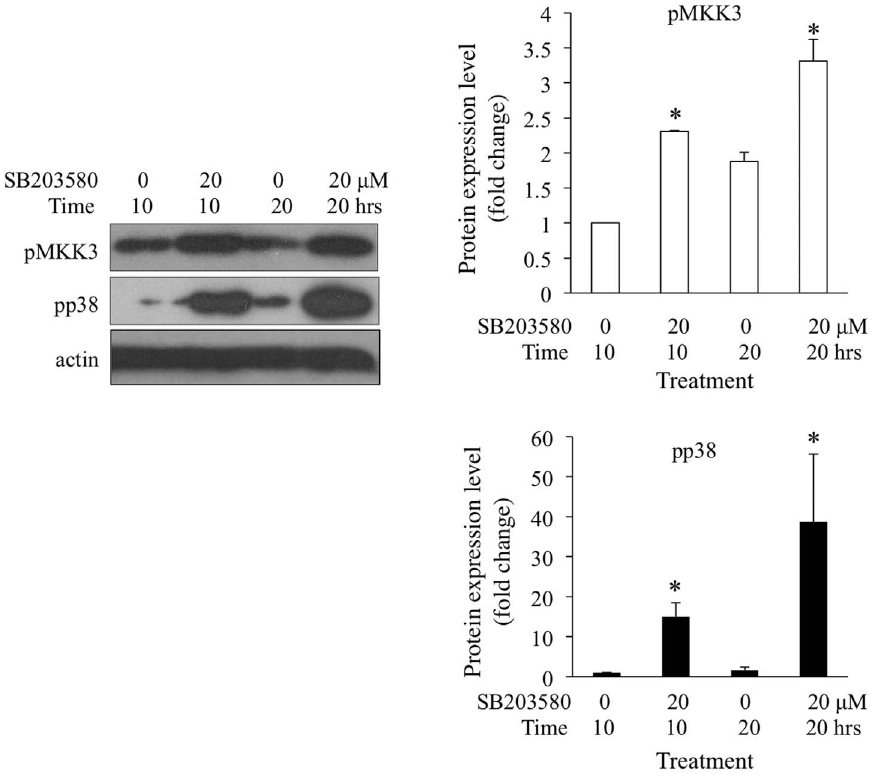
Figure 7. Treatment with p38MAPK inhibitor increased MKK3 and p38MAPK phosphorylation. Cyprids treated with 20 m M SB203580 for 10 and 20 hours were collected. Levels of pp38MAPK and pMKK3 were detected by Western blot. Untreated cyprids were blotted as control. The phosphorylation levels of p38MAPK and MKK3 in the 10-hour untreated group were normalized to a unit of 1. Student’s t -test was conducted to determine the significant levels of the differences between treated and untreated cyprids. The asterisks indicate significant differences from the untreated group within the same time course.